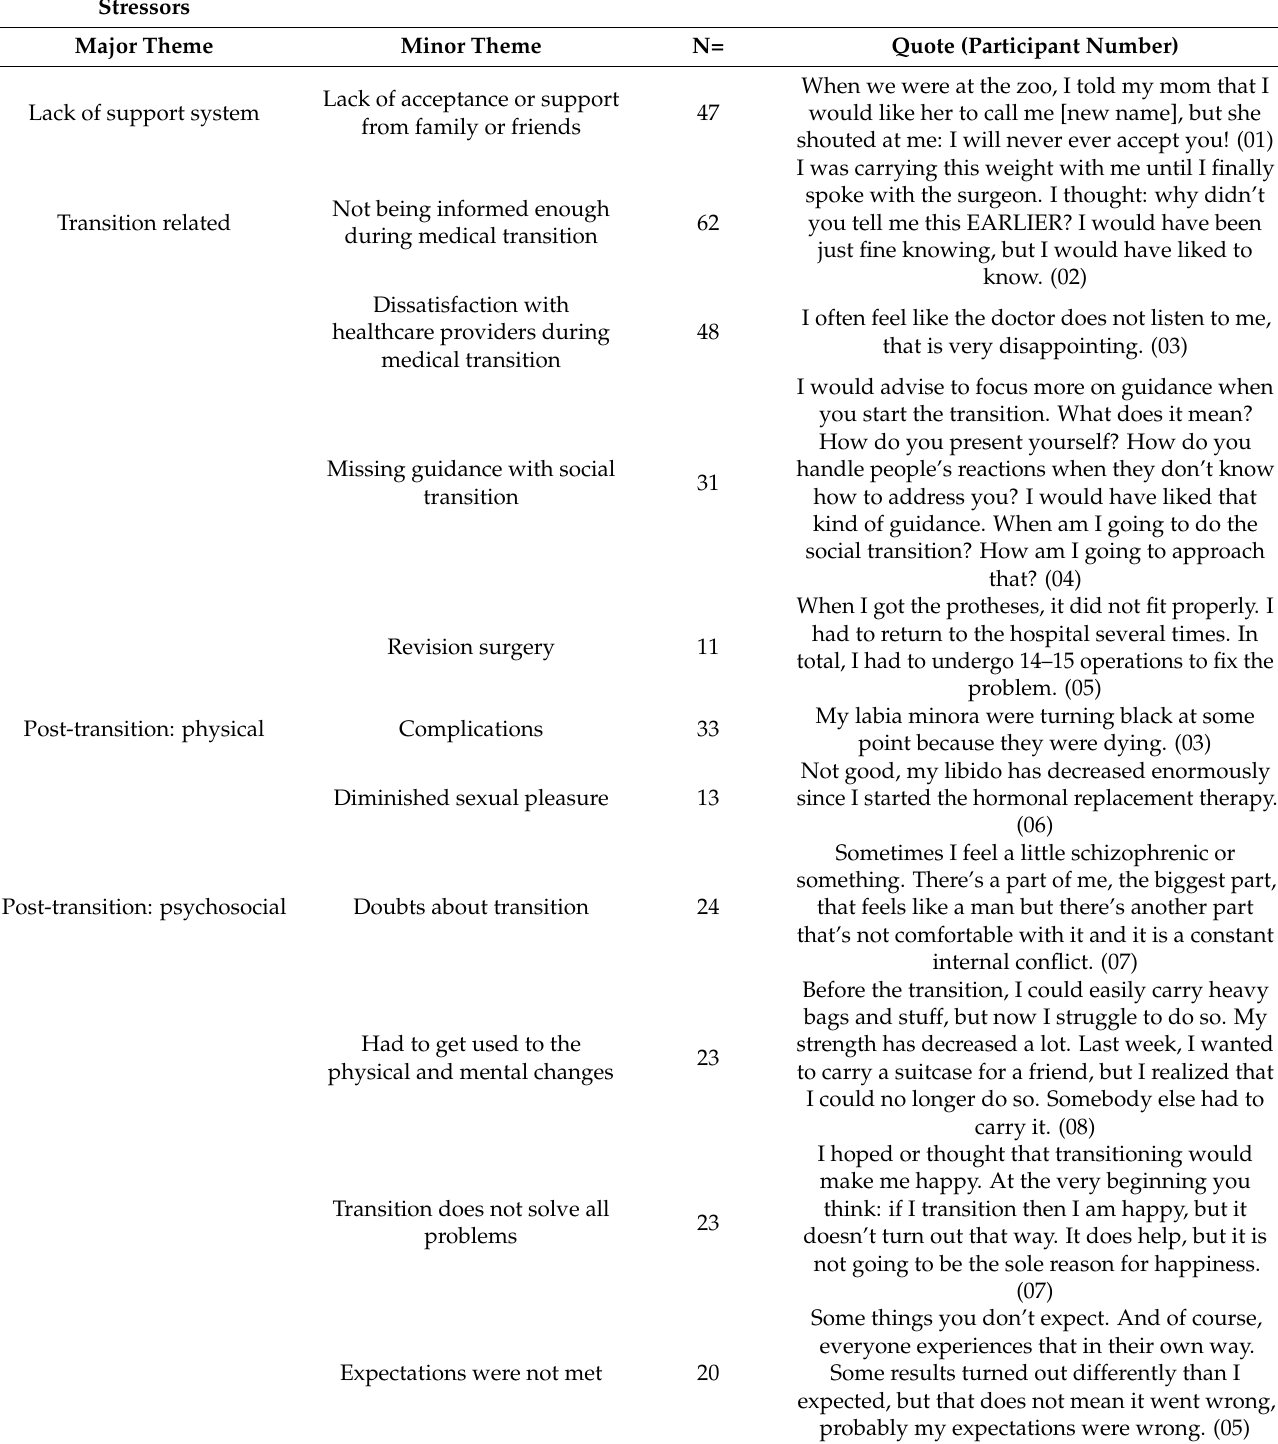
Table 2. Stressors reported during and after gender-affirming